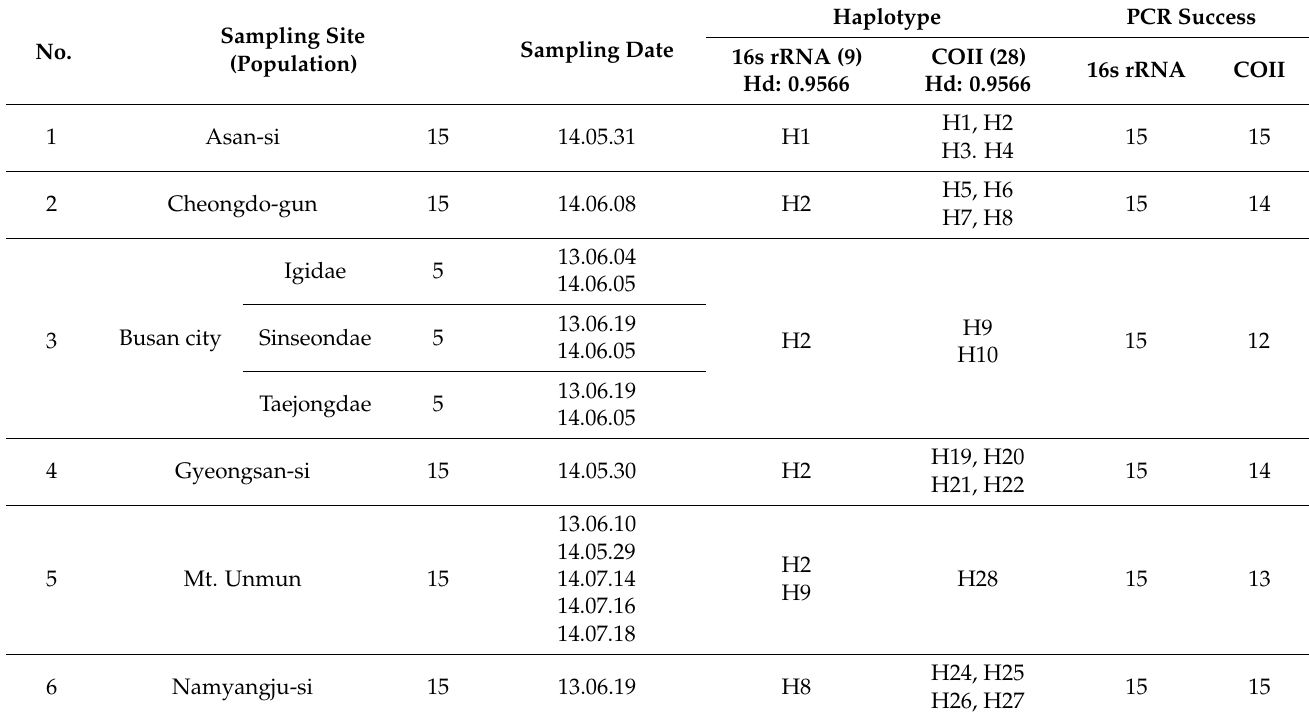
Figure 2. Views of L. unmunsana male and female adults. Table 1. L. unmunsana sampling information used for genetic